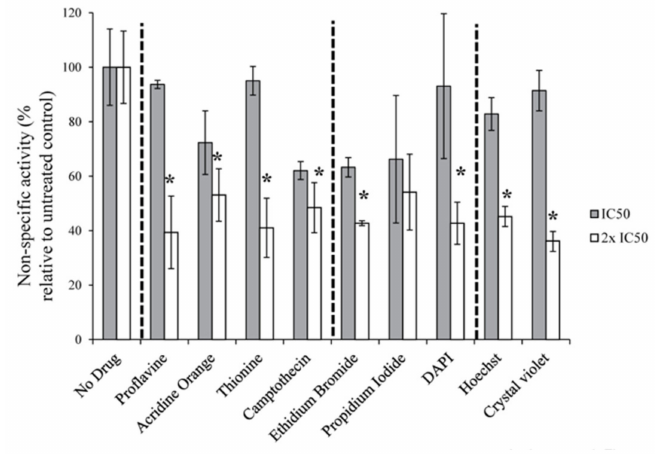
Figure 2. Pol-I synthetic activity is not affected by intercalators. 200 ng of calf thymus DNA was pre-incubated with either IC 50 or 2 × IC 50 (specific Pol-I activity, Table 1). Dashed lines separate untreated control samples ( left ), GC intercalating compounds (second from left), general DNA intercalating compounds (third from left) and AT intercalating compounds ( right ). Reactions were initiated by addition of HeLa Nuclear extract and after 30 min incubation the efficiency of non-specific RNA synthesis was determined using scintillator counter (in duplicates). The data expressed as a percentage of the highest value (set at 100%), and represents an average from two independent experiments ( n = 2); standard deviations are shown; P-values were calculated using one and two-way ANOVA on R software, * p < 0.05. IC 50 —grey bars, 2 × IC 50 —white